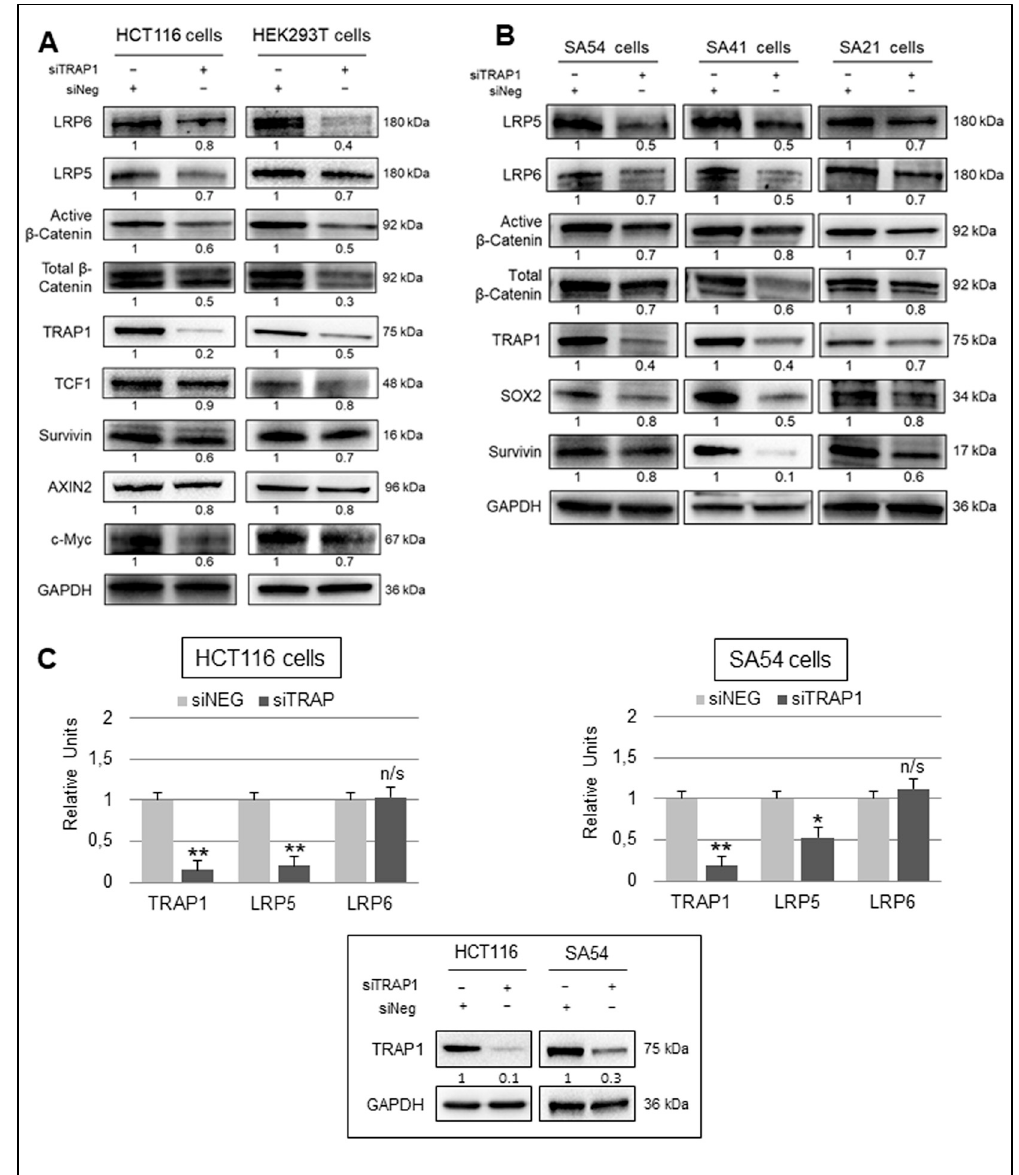
Figure 3. TRAP1 silencing results in the downregulation of LRP5/6 receptors and Wnt/ β -Catenin-related proteins. ( A , B ) Total cell lysates collected from control (siNeg) and TRAP1-silenced (siTRAP1) HCT116 and HEK293T cells ( A ), and SA54, SA41, and SA21 patient-derived spheroids ( B ) were separated by SDS-PAGE and immunoblotted with the indicated antibodies. ( C ) Real-time PCR gene expression analysis of LRP5 and LRP6 in TRAP1-silenced HCT116 and SA54 cells compared to cells transfected with negative siRNA. Statistical significance respect to siNeg control: * p < 0.05; ** p < 0.01; n/s, not significant. Data represent means + S.D.